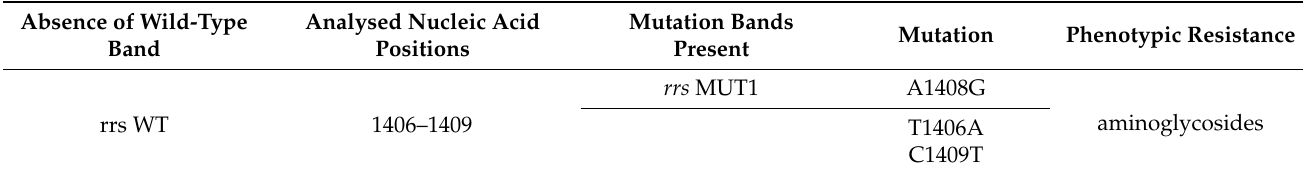
Table 2. Mutations determining resistance to aminoglycosides detected using the GenoType NTM-DR assay within the rrs